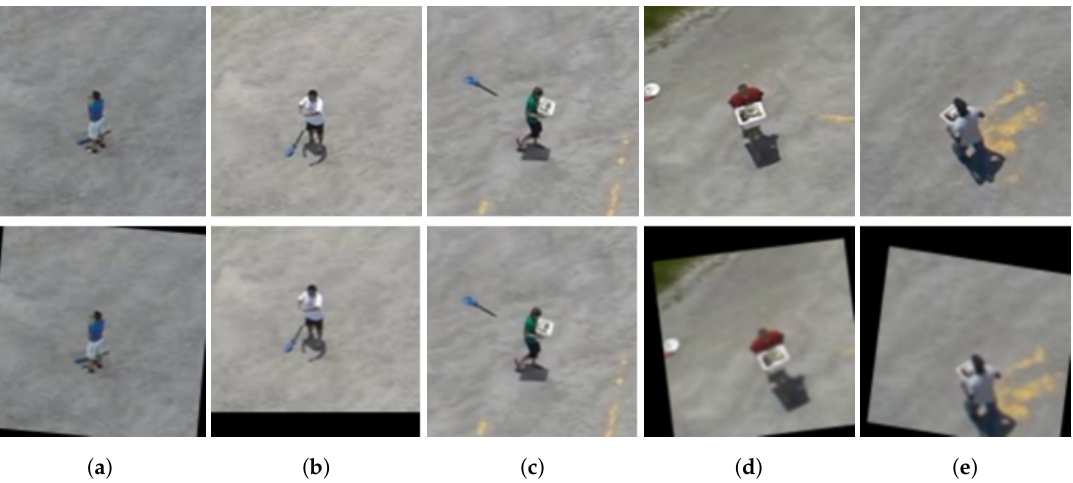
Figure 7. Data augmentation process: original and new images generated by applying the following transformations: ( a ) rotation, ( b ) translation; ( c ) scale; ( d ) rotation and translation and ( e ) rotation, translation and